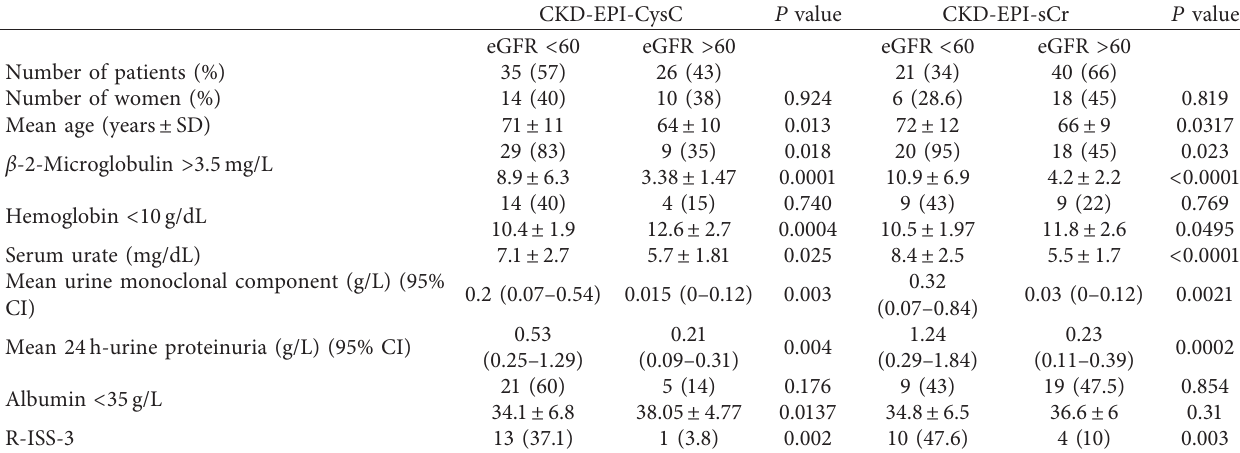
Table 3: Comparison of risk factors associated with reduced glomerular filtration rate estimated by CKD-EPI-creatinine and cystatin